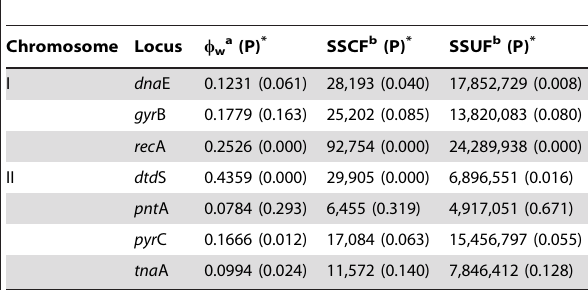
Table 2. Results of the Pairwise Homoplasy Index ( w w ) a and Sawyer’s Run Test b for homologous recombination performed on individual loci included in the MLST scheme ( dna E, gyr B, rec A, dtd S, pnt A, pry C and tna